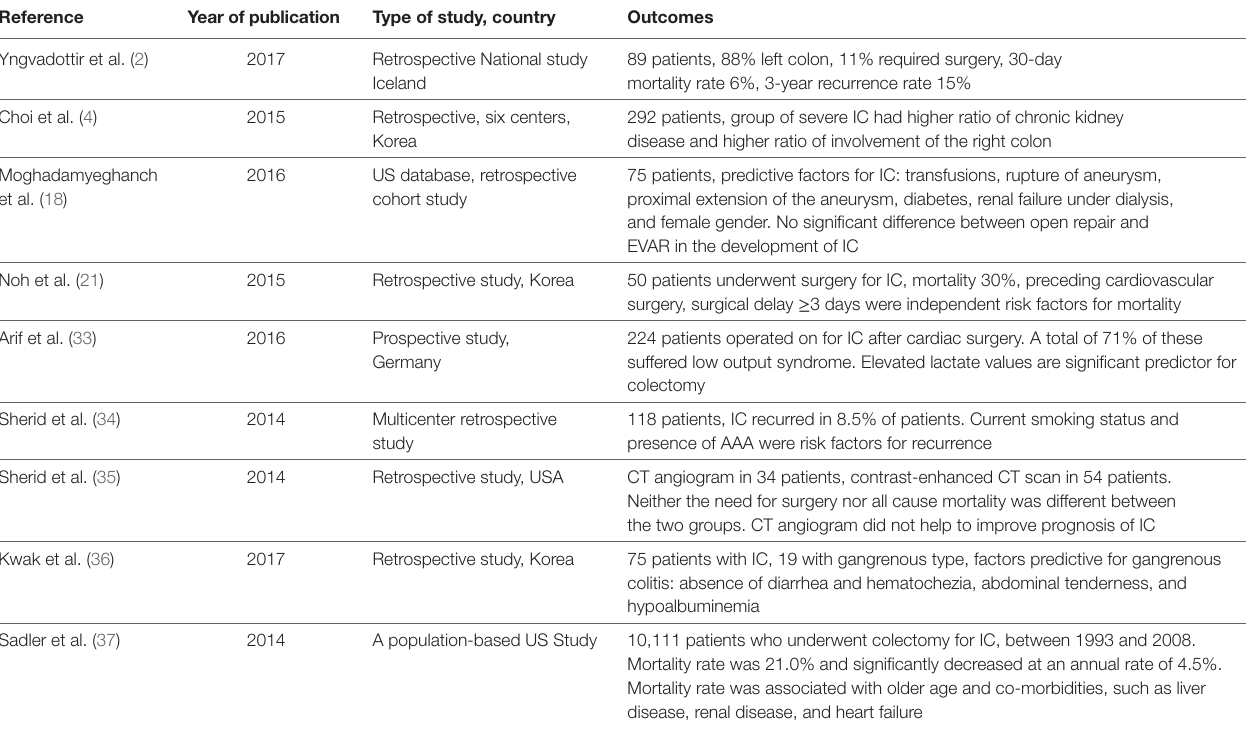
TABLe 1 | Recent (2014–2017) multicenter studies presenting outcomes of treatment of ischemic colitis (IC).